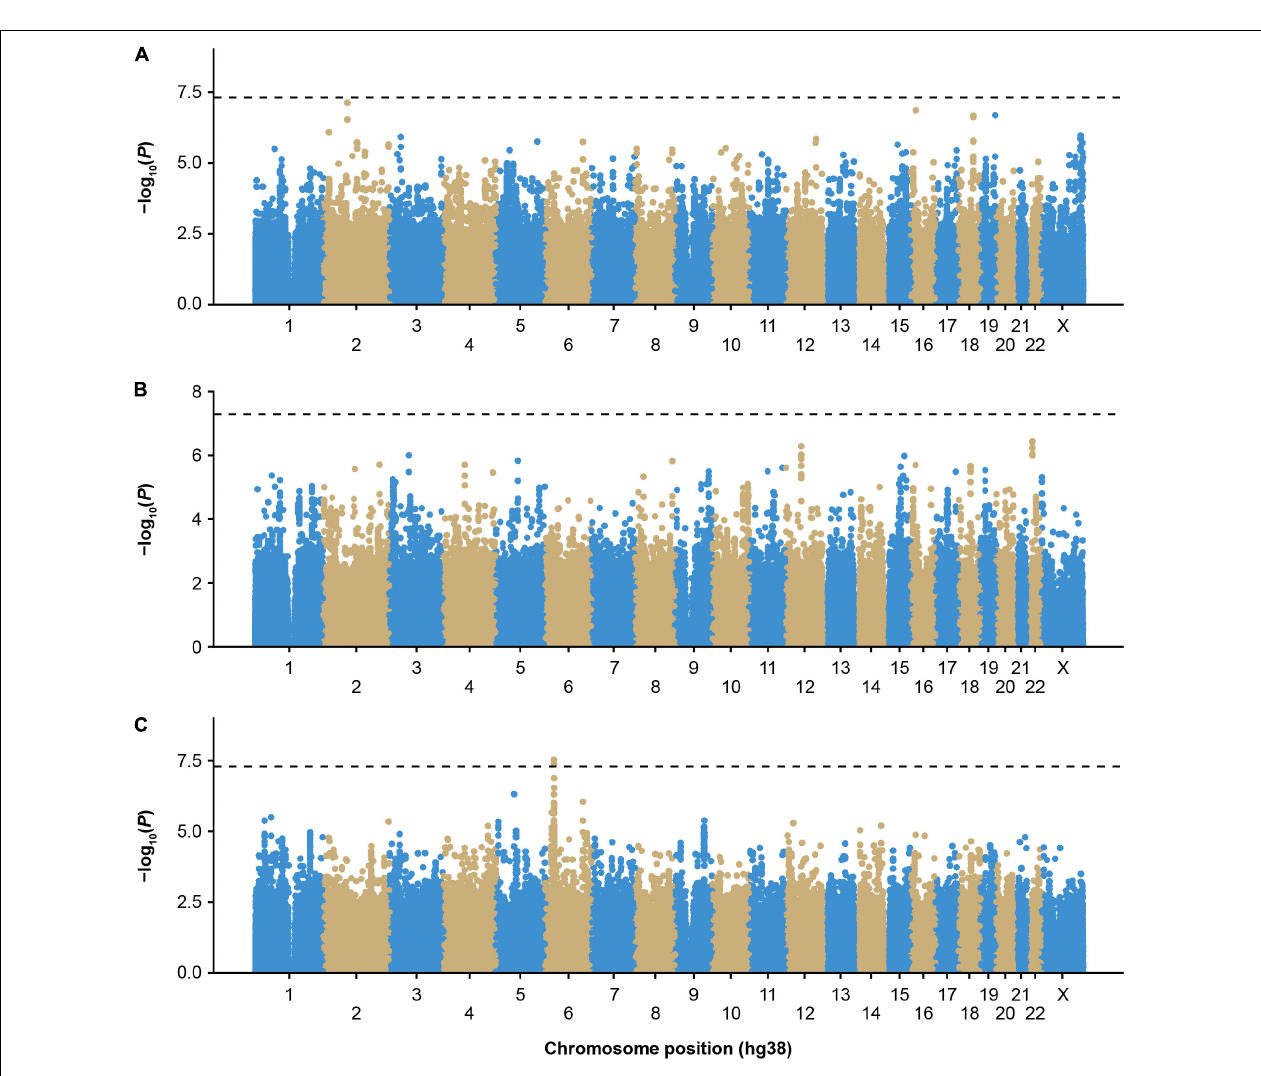
FIGURE 1 | Genome-wide association study of inhibitors in European participants of the MLOF study. (A) Participants with all-titer inhibitor hemophilia A ( N = 306 cases, N = 1,699 controls), (B) high-titer inhibitor participants ( N = 110 cases, N = 1,699 controls), and (C) participants with all-titer inhibitor hemophilia A with F8 intronic inversions ( N = 142 cases, N = 411 controls). Colors distinguish the different chromosomes. P -values were calculated by performing score tests using GMMAT after fitting logistic mixed models to account for population structure and relatedness and adjusting for age, sequencing center, F8 mutation type, severity, and the first 3 genetic principal components. P -values < 5 × 10 − 8 were considered significant. GMMAT, generalized linear mixed-model association tests; hg, human genome; MLOF, My Life, Our Future.